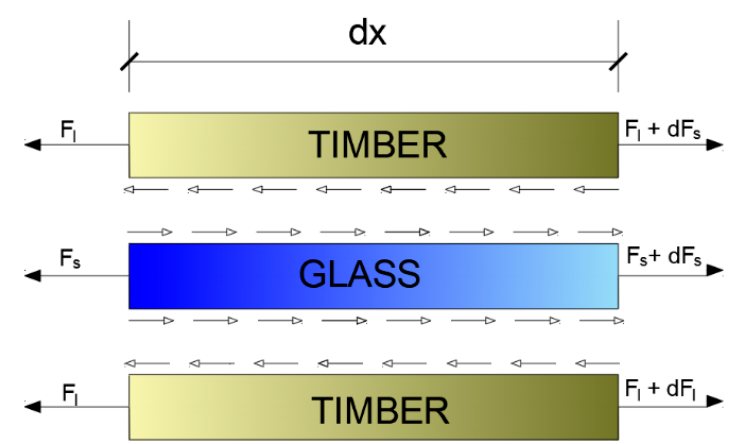
Figure 3. Differential element.